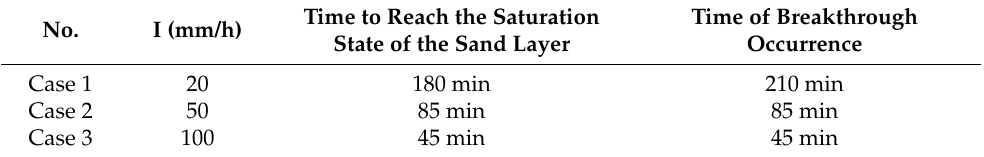
Table 4. Measurement results for each